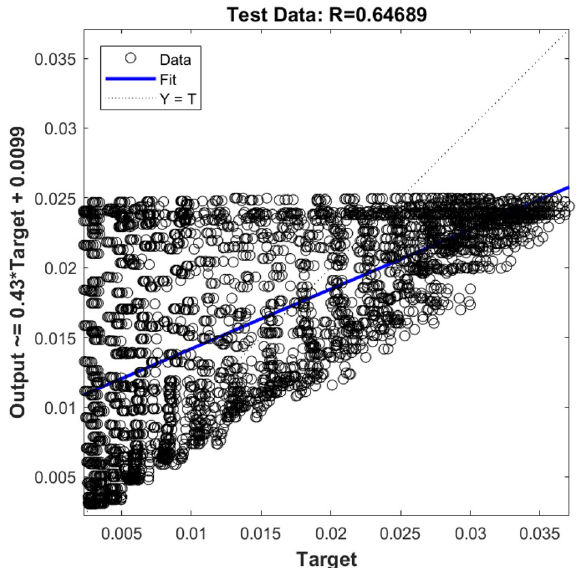
Figure 7. Testing validation of liquid velocity for the ANFIS model with one input. The ANFIS model’s output is the liquid velocity distribution, and it is validated against the velocity component (x-direction) in the CFD calculation (target